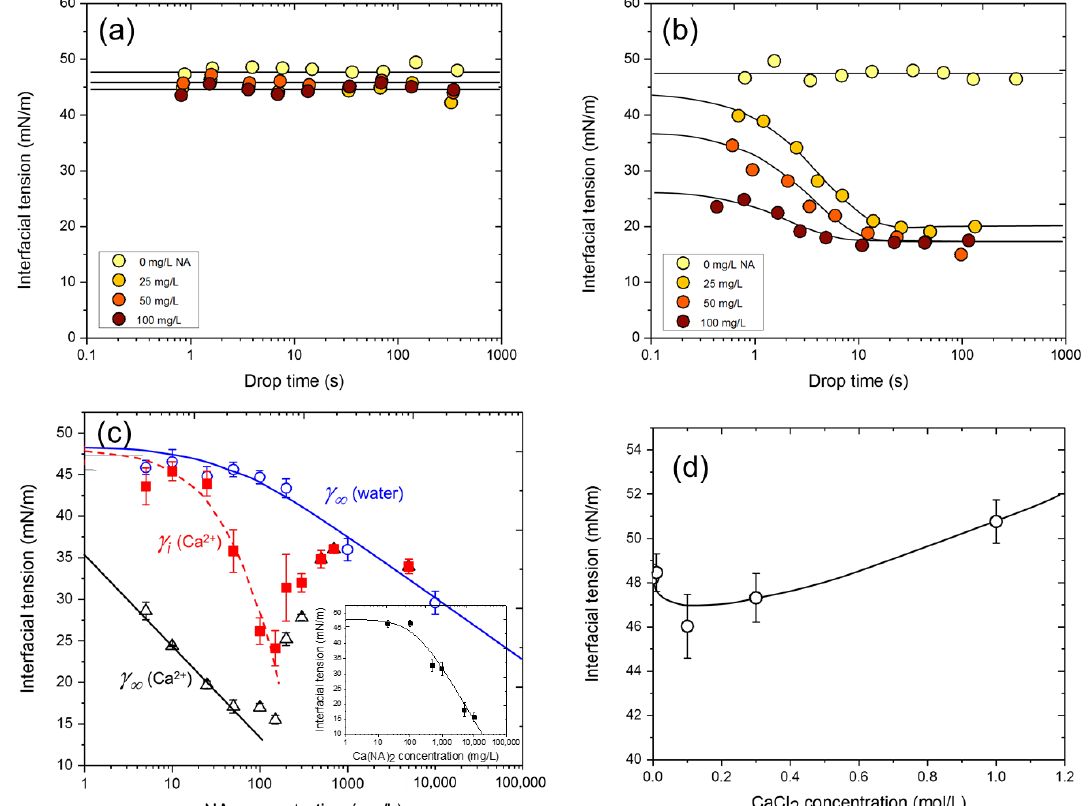
Figure 2. ( a ) Examples of the dynamic interfacial tension of naphthenic acid solutions in n -heptane against deionized water. ( b ) Corresponding results against water containing 0.3 mol/L Ca 2+ . ( c ) Interfacial tension-log (naphthenic acid concentration) profiles for deionized water and the individual γ i and γ ∞ contributions for 0.3 mol/L Ca 2+ (see Equation (8)). The inset shows the corresponding plot for n -heptane solutions of Ca(NA) 2 against deionized water. All curves are fits to the Szyszkowski equation (Equation (9)). ( d ) The effect of Ca 2+ concentration on the interfacial tension of the n -heptane/water interface. The line is based on the empirical equation γ = γ 0 − Aγ 0.5 + Bγ as described in the text.